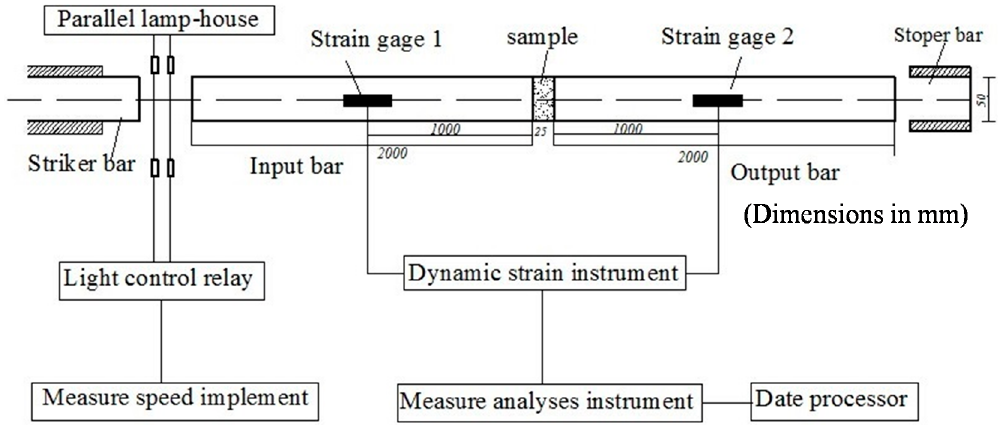
Figure 2. SHPB apparatus.